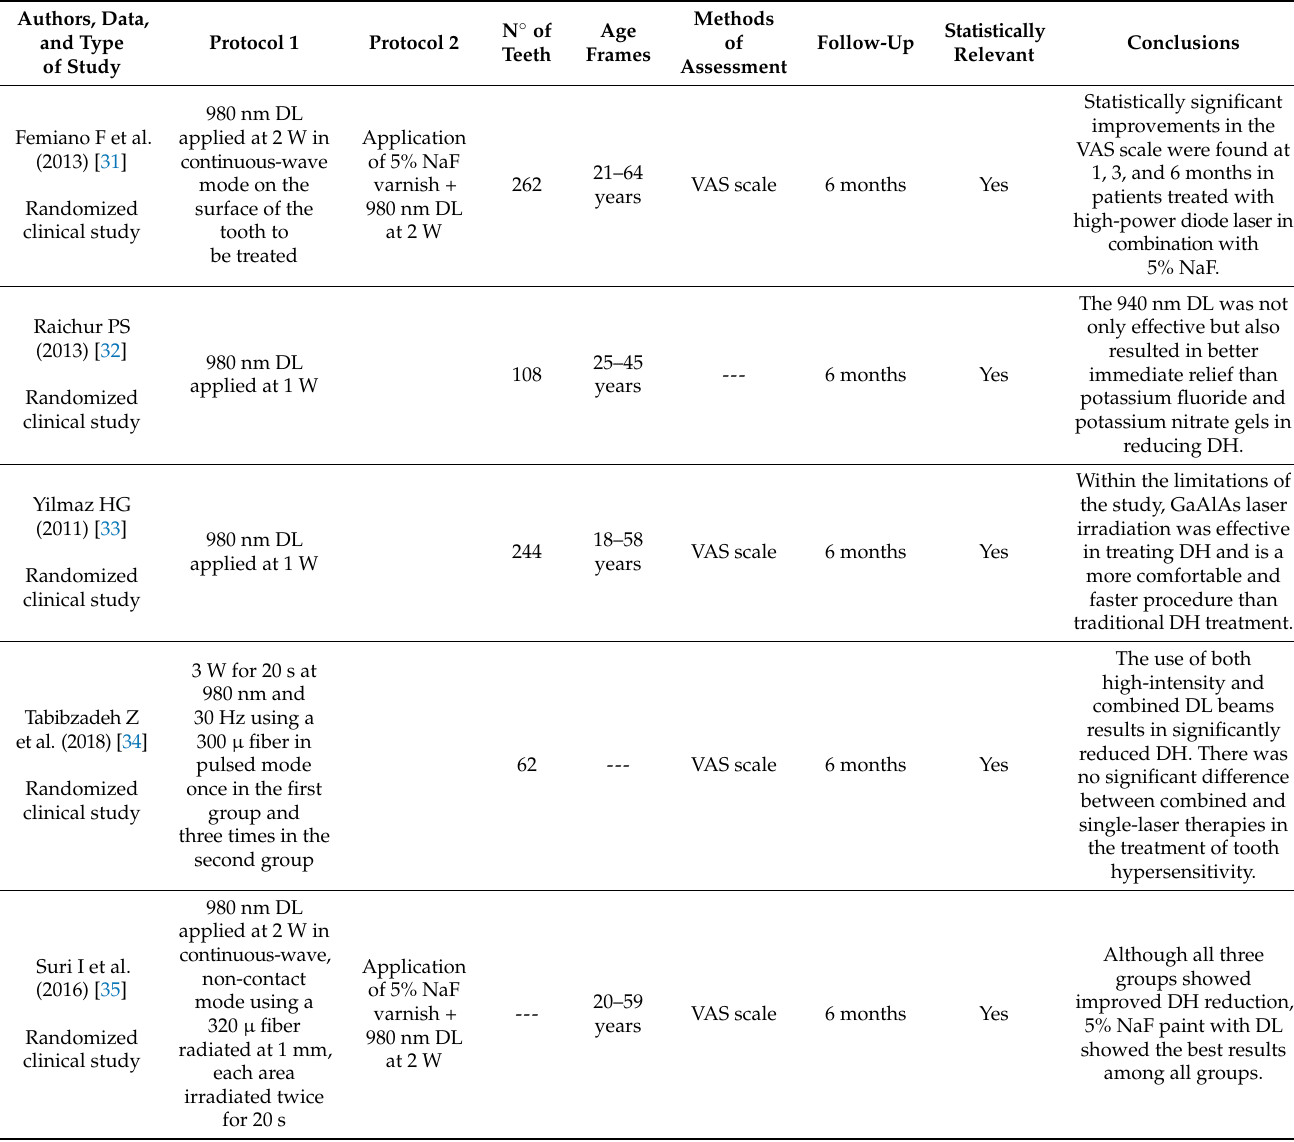
Table 3. Characteristics of the included studies on the use of high-power diode lasers in dentinal hypersensitivity